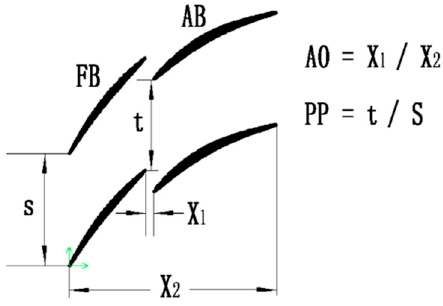
Figure 1. Sketch map of a tandem blade.